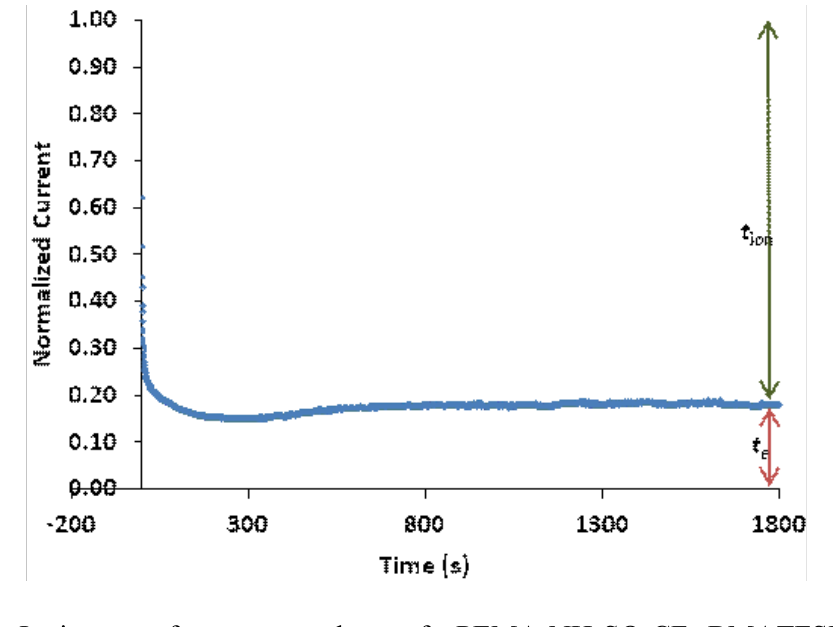
SO CF -BMATFSI polymer 4 3 3